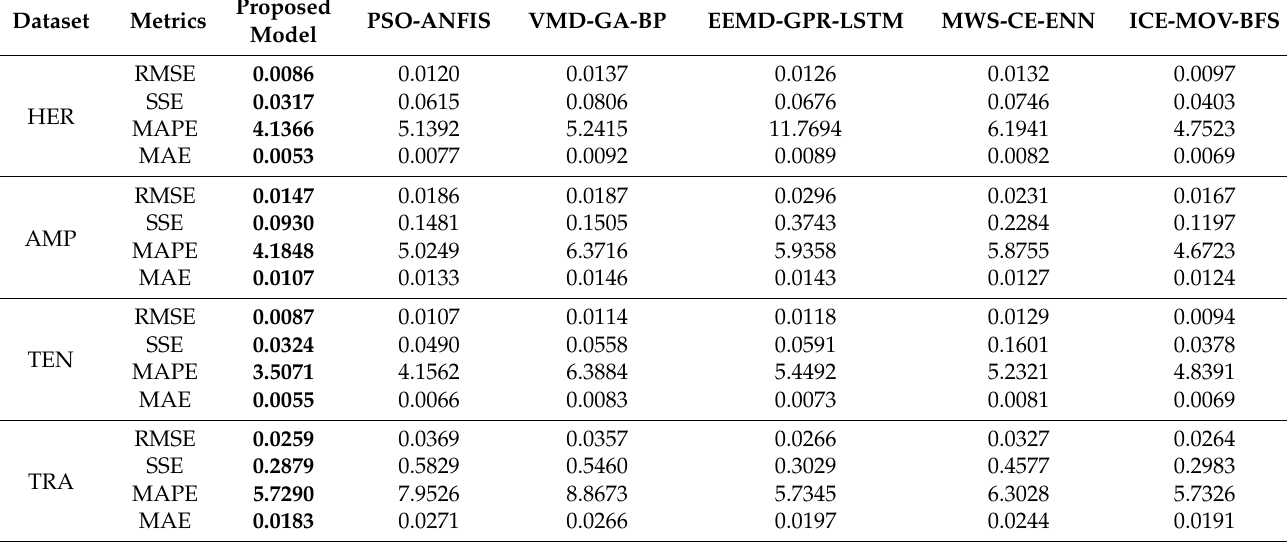
Table 3. Forecasting performances of the proposed model and reference